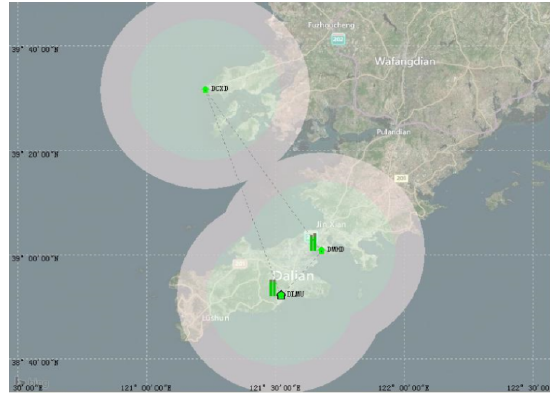
Figure 6. Distribution of DLMU-CORS network.